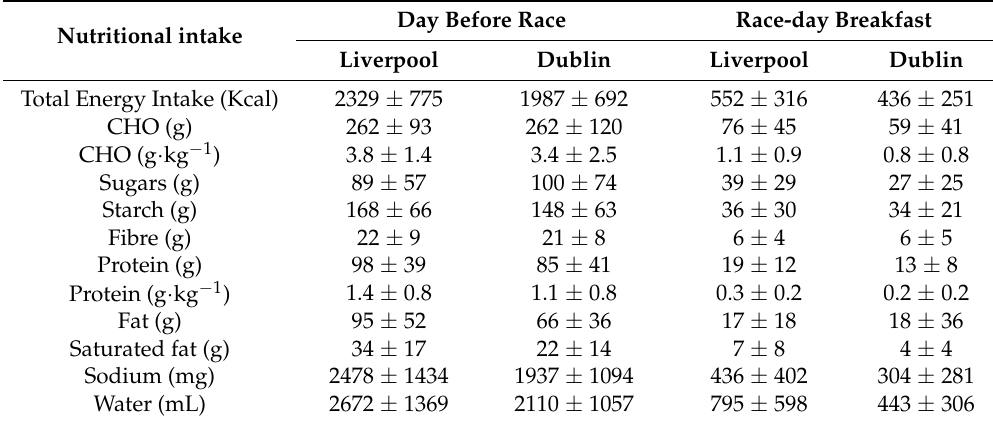
Table 3. Nutritional intake during the marathon race. Nutritional intake